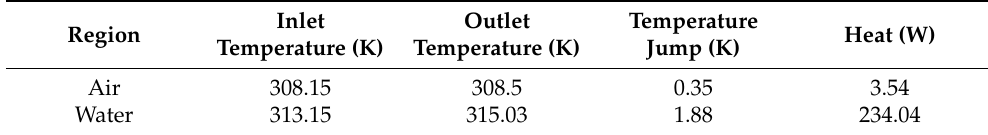
Table 3. Calculated heat transfers from the CPUs to the air and water.